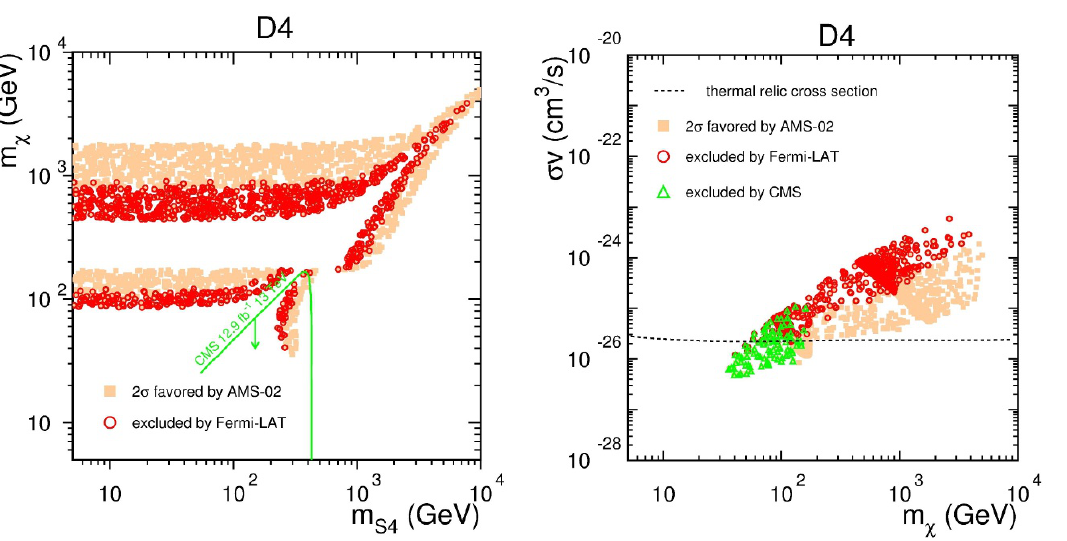
Figure 6 . Left: the AMS-02 favored region of masses ( m (cid:31) vs. m S model D 4 . Right: the AMS-02 favored region of cross sections ( (cid:27)v vs. m (cid:31) ).